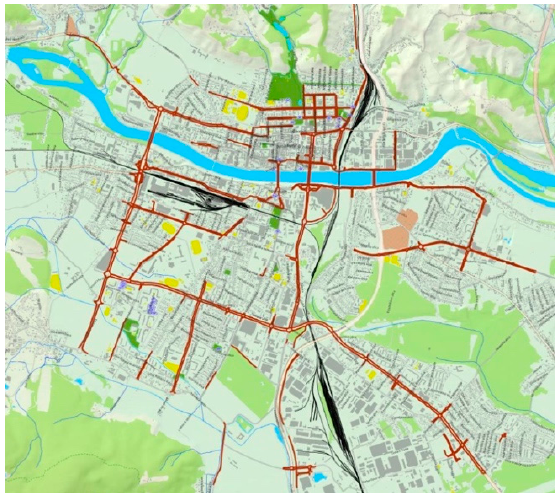
Figure 4. Cycling network in Maribor [4].